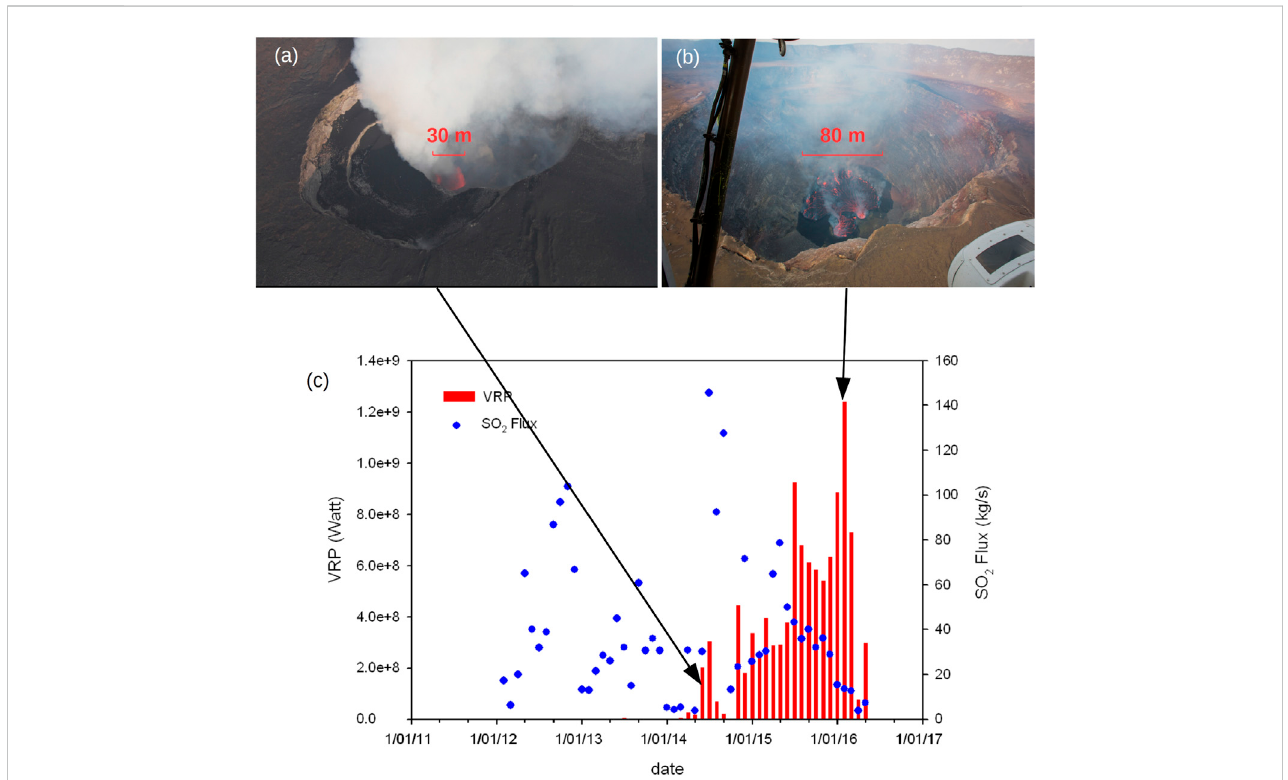
FIGURE 4 (A) Small fountaining lava lake in the newly-formed collapse pit in Nyamuragira ’ s Caldera in June 2014 (photo: D. Tedesco). (B) View of the mature lava lake in February 2016. Note the increase in lake size and the notable decrease in plume vigor (photo: G. Kourounis). (C) Time series of the SO 2 fl ux and daily Volcanic Radiative Power from Nyamuragira volcano. Inter-eruptive SO 2 fl ux before 2012 was close to